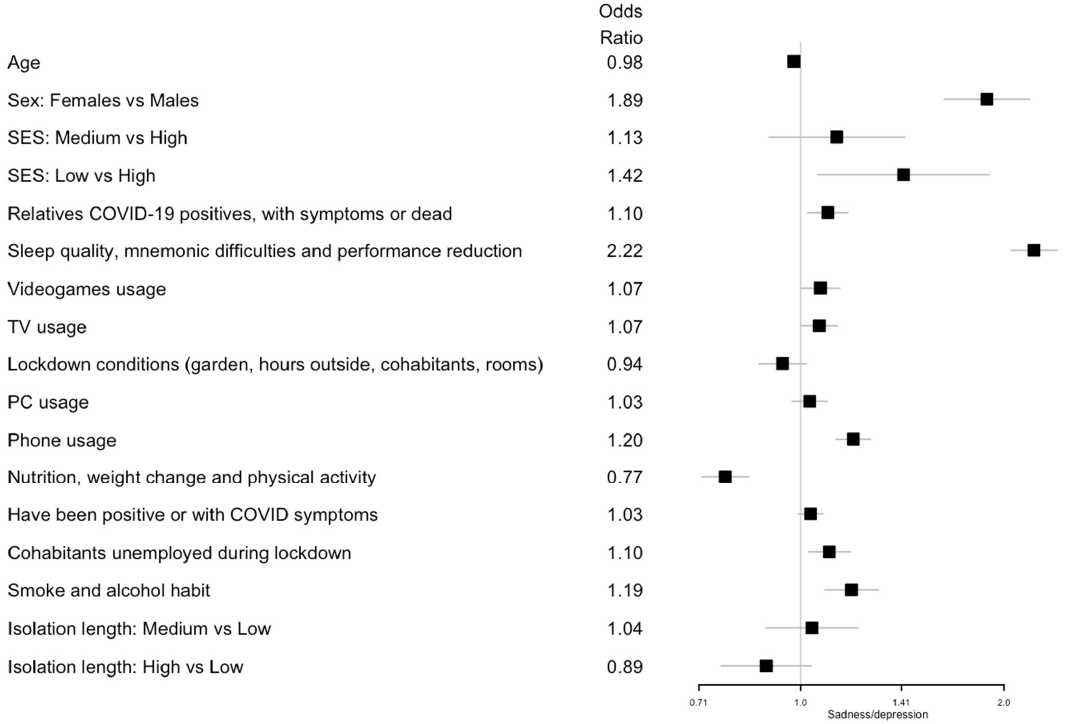
Figure 5. Forest plots for the effect of the covariates on sadness/depression. The squares represent the odds ratios and the lines depict the confidence intervals estimated by the ordinal logistic regression.